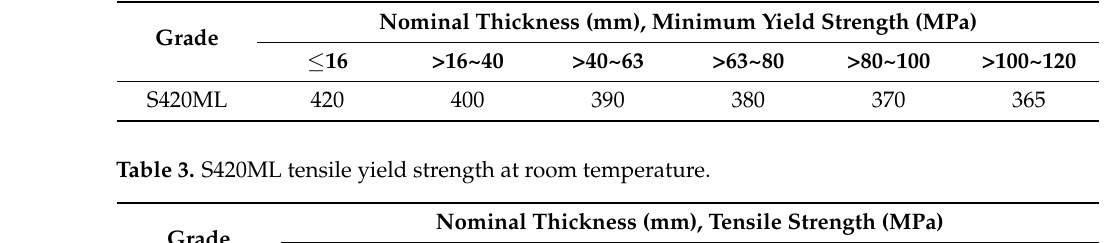
Table 2. S420ML minimum yield strength at room temperature.